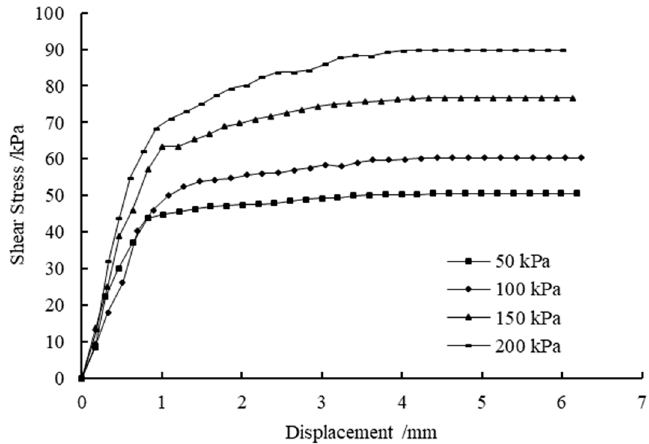
Figure 9. The stress–displacement curve of the soil samples treated with 27.5% CaCl 2 followed by 21.2% Na 2 CO 3 solutions.